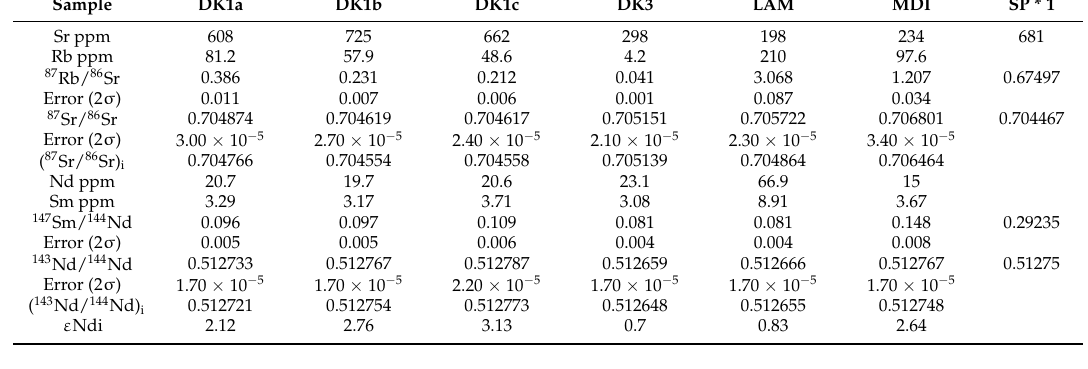
Table 7. Results for Rb-Sr and Sm-Nd isotopic systems in samples of post-mineralization dykes from Sungun. Initial values were calculated for an age of 20 Ma, using the 147 Sm decay constant of and the 87 Rb decay constant of [45]. (* [25]). Sample DK1a DK1b DK1c DK3